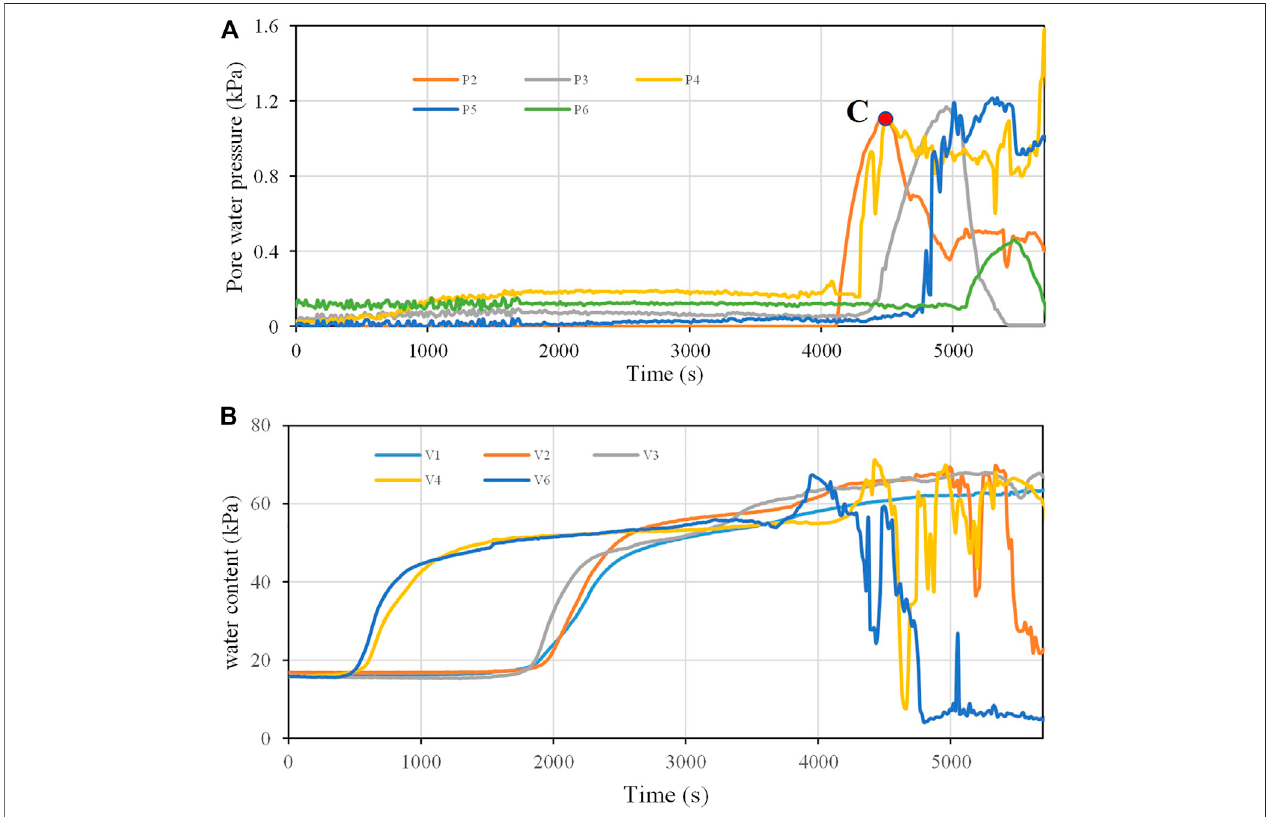
FIGURE 6 | Variations in pore water pressure and water content with time in the fl ume test with a slope angle of 15 ° . (A) Pore water pressure; (B) Water content. Discussion of the initiation mechanisms of loess mud fl ows.